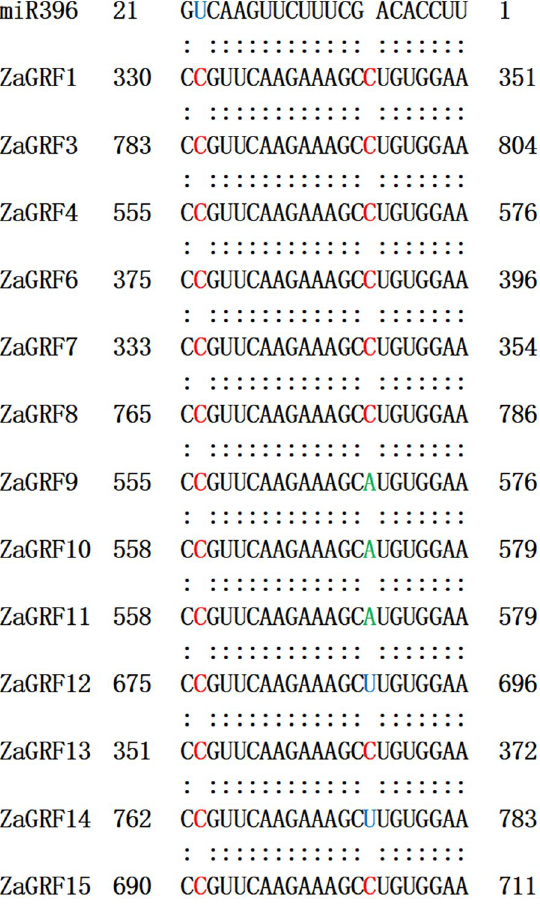
Figure 2. Prediction of miR396 targets of ZaGRF genes.